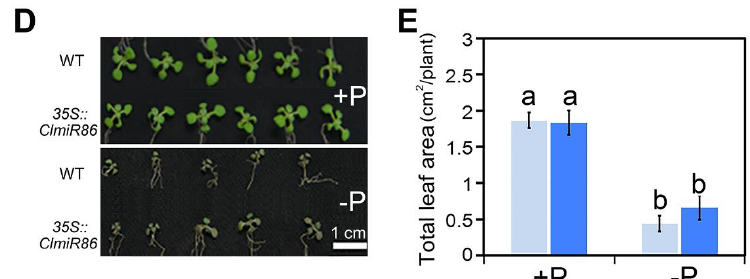
Figure 5. Ectopic expression of ClmiR86 enhanced Arabidopsis root growth under P starvation at early stage. ( A ) Root phenotype of wild type (WT; Col-0) and 35S::ClmiR86 Arabidopsis when grown on +P or –P MS medium for 7 days. ( B ) Primary root length of wild type and 35S::ClmiR86 seedlings when grown under P sufficient or deficient conditions. ( C ) Lateral root number of the wild type and 35S::ClmiR86 seedlings under P sufficient or deficient conditions. ( D ) Leaf phenotype of wild type (WT; Col-0) and 35S::ClmiR86 Arabidopsis when grown on +P or –P MS medium for 7 days. ( E ) Leaf